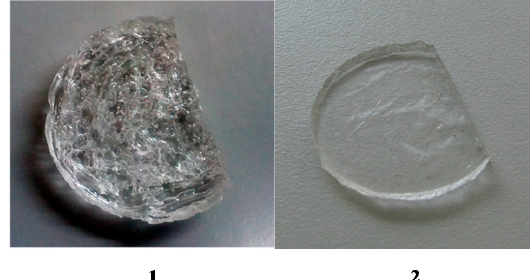
Figure 3. Photographs of the PDMS − EHDMS rubbers obtained in the presence of Karstedt’s catalyst (1.0 × 10 − 5 mol/L) ( 1 ) and cis - 4 (5.0 × 10 − 5 mol/L) ( 2 ) at RT, τ curing is 6 h and 36 h, respectively.